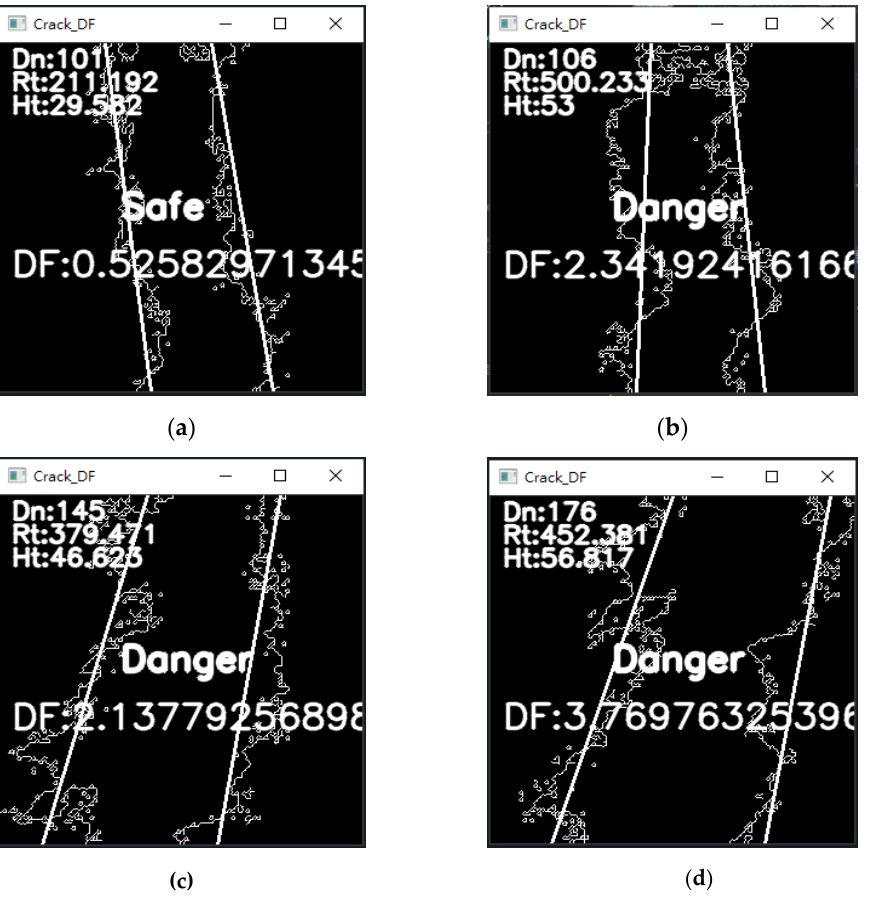
Figure 18. ( a ) No. 10 dangerous gap evaluation results. ( b ) No. 12 dangerous gap evaluation results.